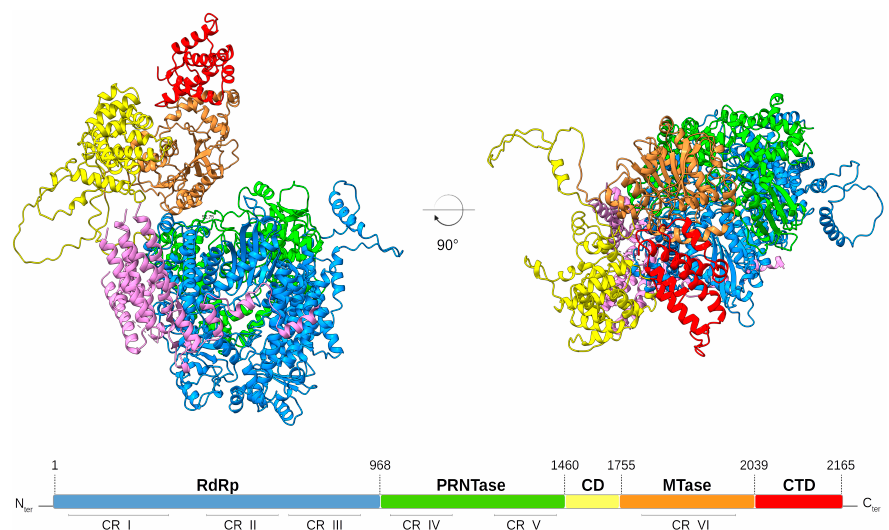
Figure 1. Structural model of the RSV L protein. The RSV L domains were structurally modeled and are shown as ribbons colored in: blue, RNA-dependent RNA-polymerase (RdRp) domain; green, polyribonucleotidyl-transferase (PRNTase) domain; yellow, connector domain (CD); orange, methyltransferase (MTase) domain; red, C-terminal domain (CTD); purple, tetrameric phosphoprotein aligned from the RSV polymerase complex structure (PDB: 6PZK). The linear scheme shows the RSV L protein domain organization with amino acid residue numbers indicating the functional domain boundaries. The conserved regions (CR) within the L proteins of NNS RNA viruses are indicated. RSV L structure was predicted by AlphaFold2 and interpreted with AlphaPickle [63,64] . Figures were prepared with CHIMERAX [65,66] .